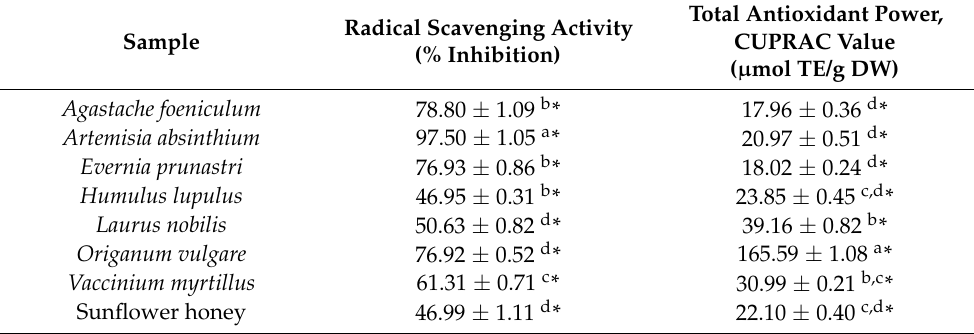
Table 3. Antioxidant activity of extracts from Agastache foeniculum , Artemisia absinthium , Evernia prunastri , Humulus lupulus , Laurus nobilis , Origanum vulgare , Vaccinium myrtillus and sunflower honey . Results are given as mean values of three independent replicates ± standard deviation. Total Antioxidant Power, Radical Scavenging Activity Sample CUPRAC Value (% Inhibition) ( µ mol TE/g DW) Agastache foeniculum 78.80 ± 1.09 b * 17.96 ± 0.36 d * Artemisia absinthium 97.50 ± 1.05 a * 20.97 ± 0.51 d * Evernia prunastri 76.93 ± 0.86 b * 18.02 ± 0.24 d * Humulus lupulus 46.95 ± 0.31 b * 23.85 ± 0.45 c,d * Laurus nobilis 50.63 ± 0.82 d * 39.16 ± 0.82 b * Origanum vulgare 76.92 ± 0.52 d * 165.59 ± 1.08 a * Vaccinium myrtillus 61.31 ± 0.71 c * 30.99 ± 0.21 b,c * Sunflower honey 46.99 ± 1.11 d * 22.10 ± 0.40 c,d